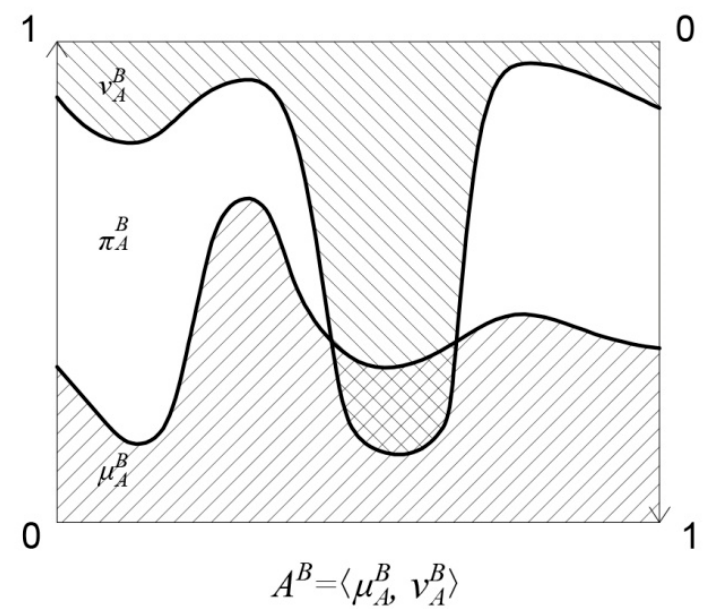
Figure 9. Graphical representation of an arbitrary LBIFS.